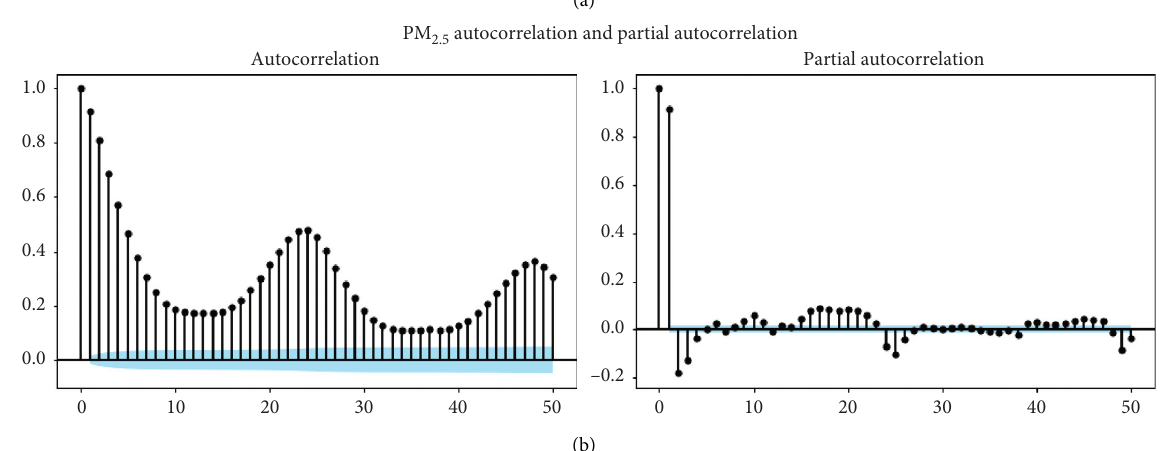
Figure 5: ACF and PACF plots for SO